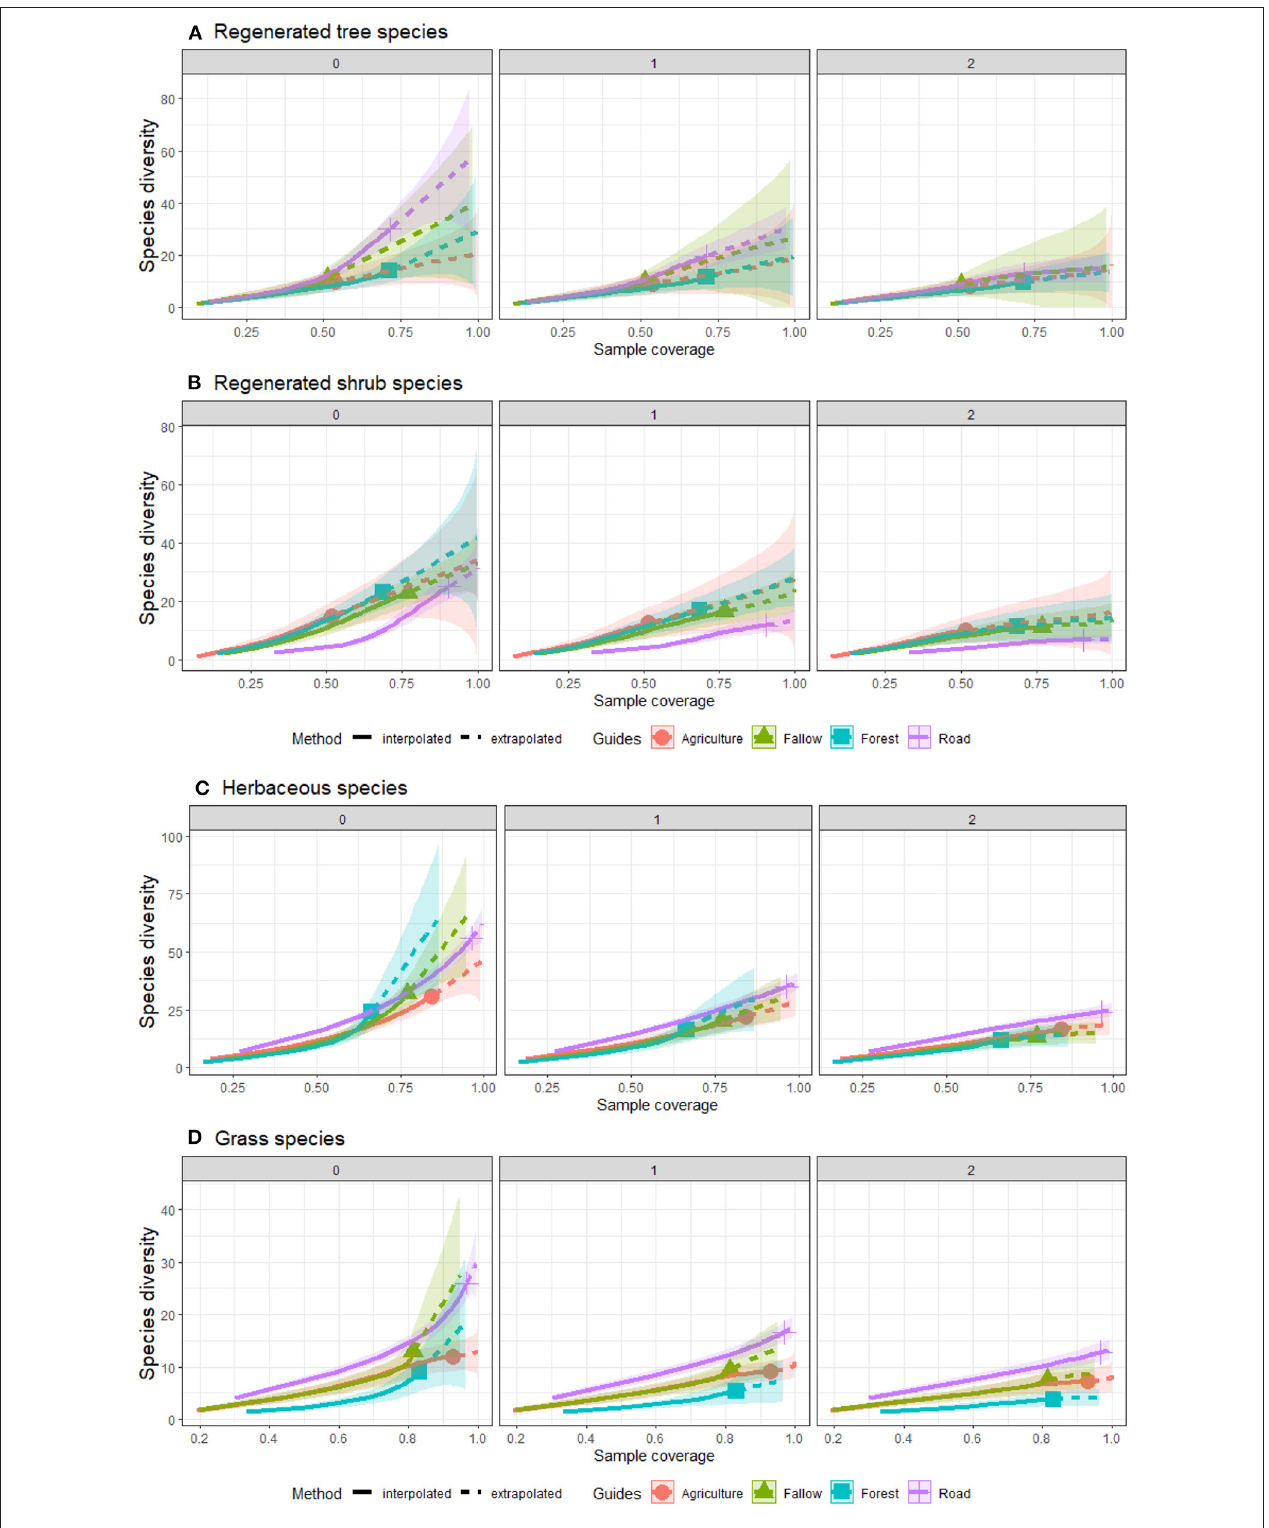
FIGURE 2 | Comparison of sample coverage-based interpolation and extrapolation for species richness ( q = 0), Shannon index ( q = 1) and Simpson index ( q = 2), across four land-uses for (A) tree, (B) shrub, (C) herbaceous, and (D) grass in Moribane Forest Reserve, central Mozambique.